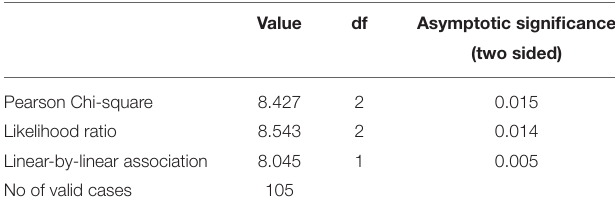
TABLE 5 | Statistical significance of the differences between patients in the two